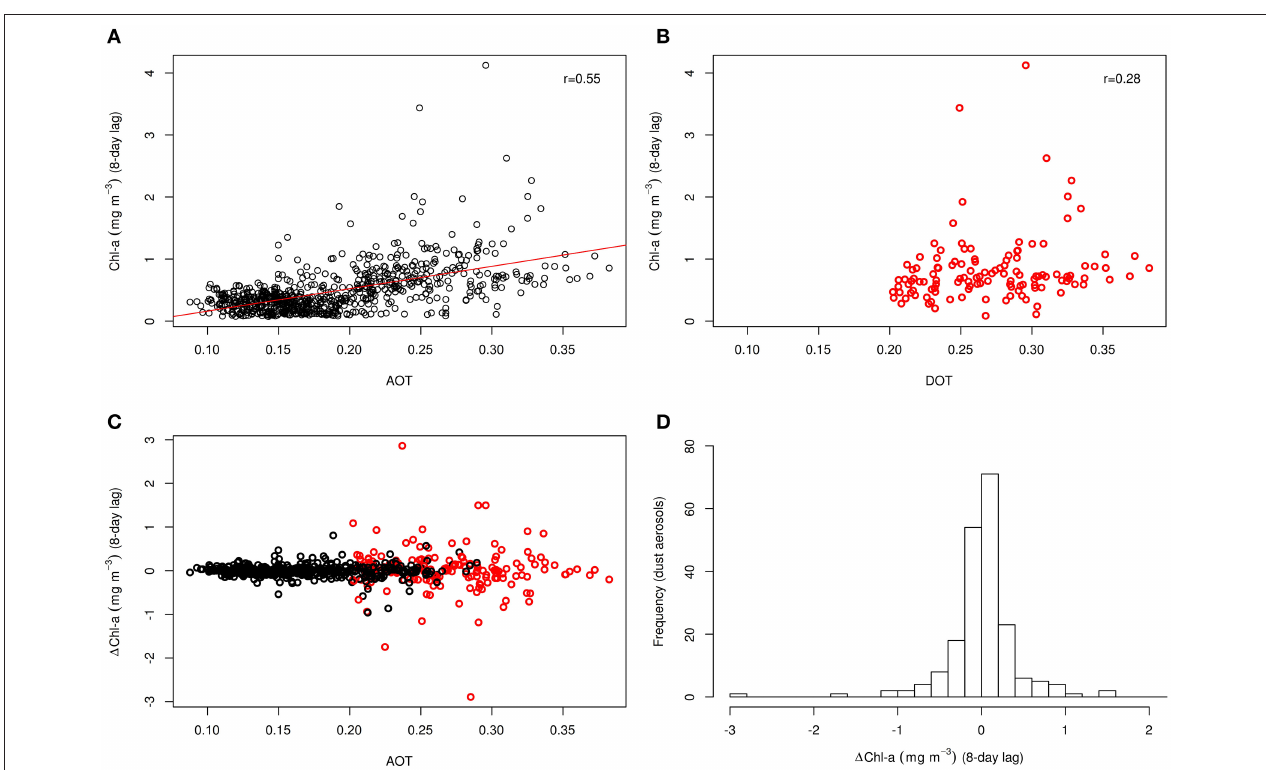
FIGURE 5 | (A) The scatter plot between 8-day composite AOT (NASA-AOT) and Chl-a with lag of one time steps, for the study area. The straight line in red colour indicates the regression equation and the correlation coefficient ( r ) is shown in the top right side. (B) Scatter plot between DOT and Chl-a with lag of one time steps (subset of all the data points in (A) . (C) Scatter plot between AOT and 1 Chl-a with lag of one time step. The circles in red colour indicate dust aerosols. (D) Histogram for 1 Chl-a during the presence of dust aerosols with lag of one time steps.